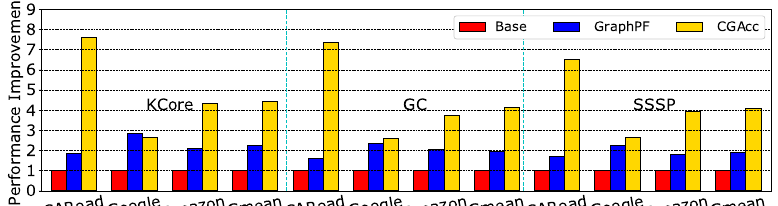
Figure 19. Comparison of the performance between the baseline, graph prefetcher and CGAcc on BFS-like applications. GC, Graph Coloring; SSSP, Single-Source-Shortest-Path.